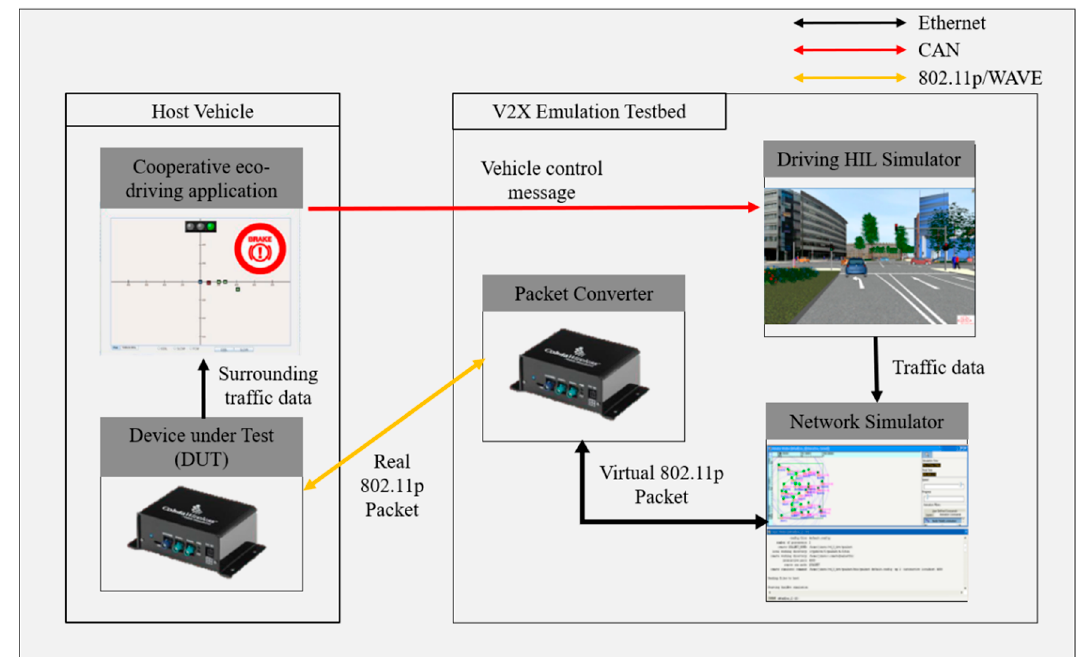
Figure 3. V2X network emulation using V2X communication devices.